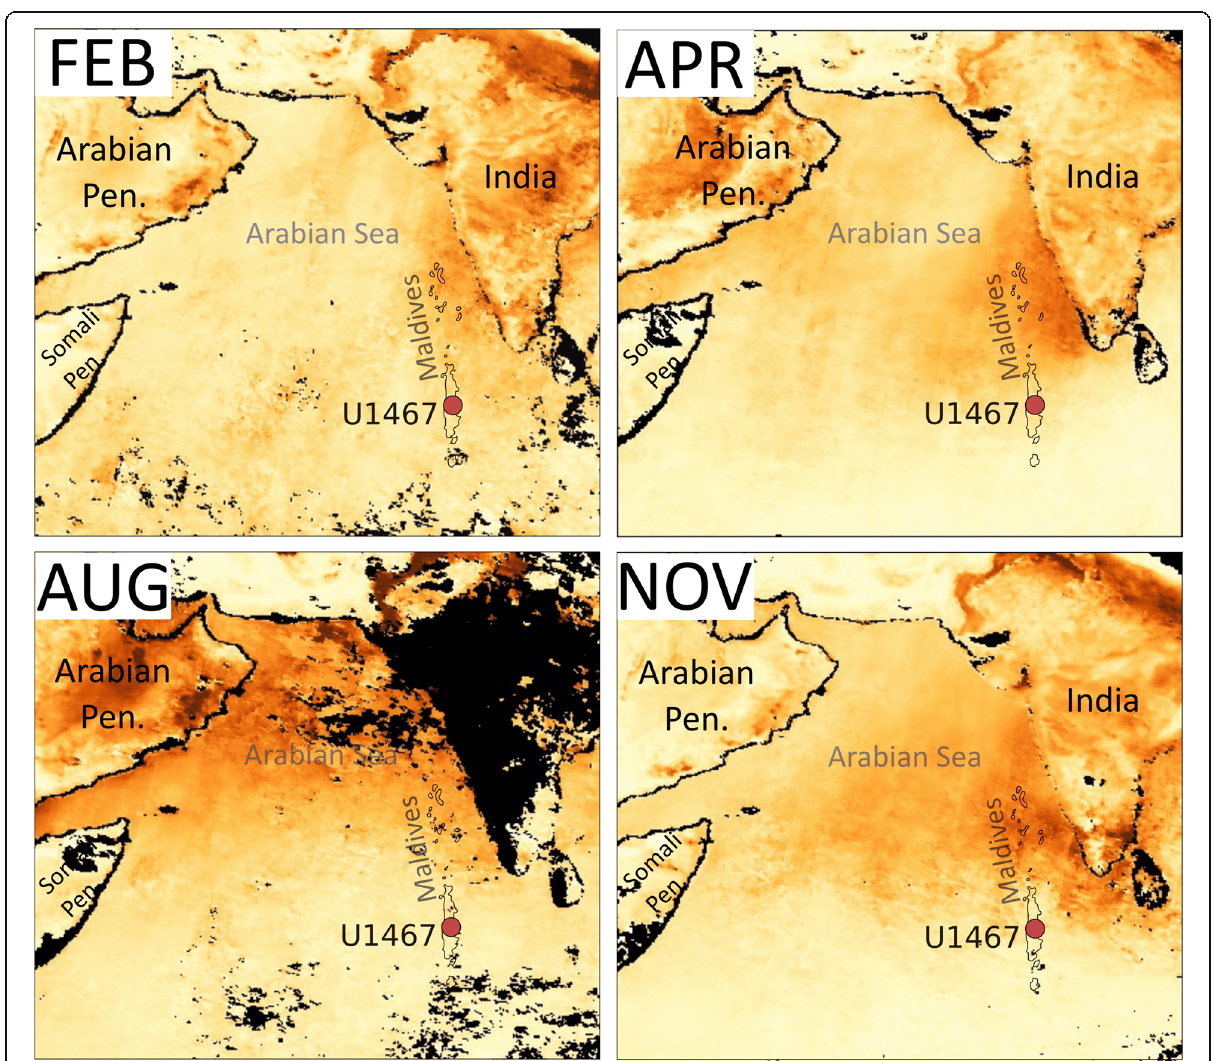
Fig. 3 A compilation of aerosol distribution in the northern Indian Ocean during selected months during 2017 (Aerosol Optical Thickness, NASA, n.d.). Note that the winter dust plume reaches the